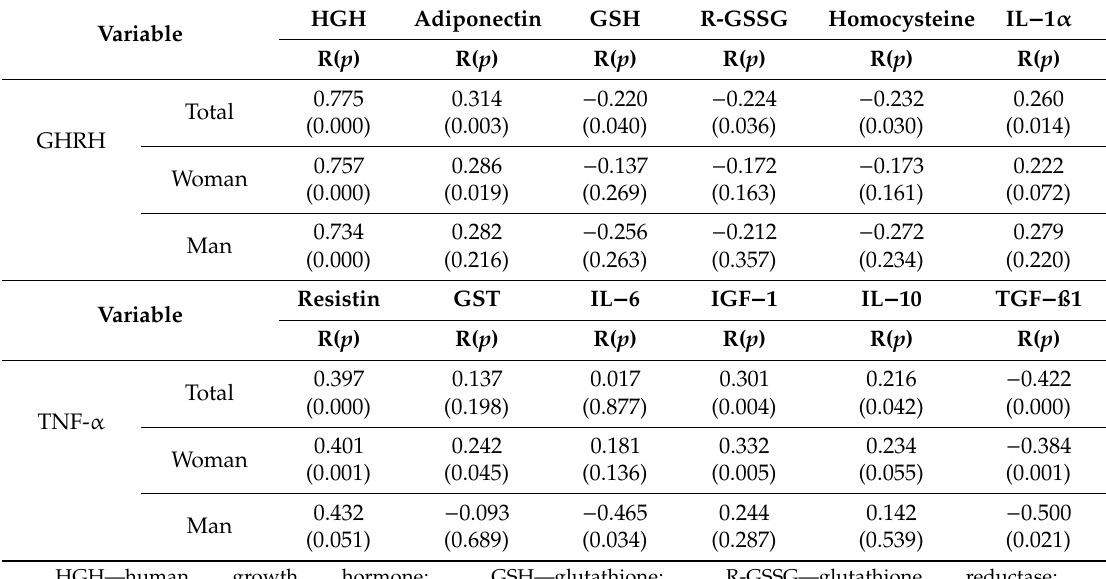
Table 5. The Spearman rank correlation analysis for growth hormone–releasing hormone (GHRH) and TNF- α , including selected variables in the general group, men and women.